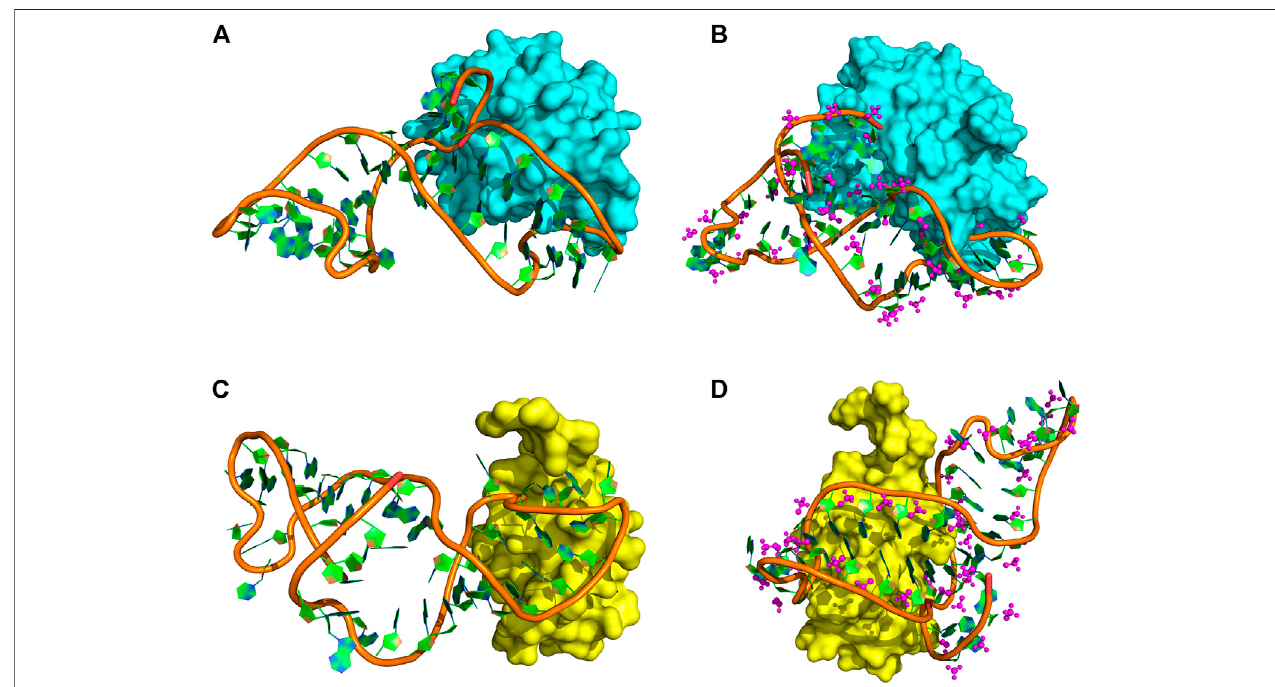
FIGURE 4 | Protein – DNA complex docking models. (A) DEK_N/DTA complex. (B) DEK_N/DTA_OMe complex. (C) DEK_C/DTA complex. (D) DEK_C/DTA_OMe complex. Cyan and yellow represent the DEK_N and DEK_C proteins, respectively. The magenta ball-and-stick represents the methoxy